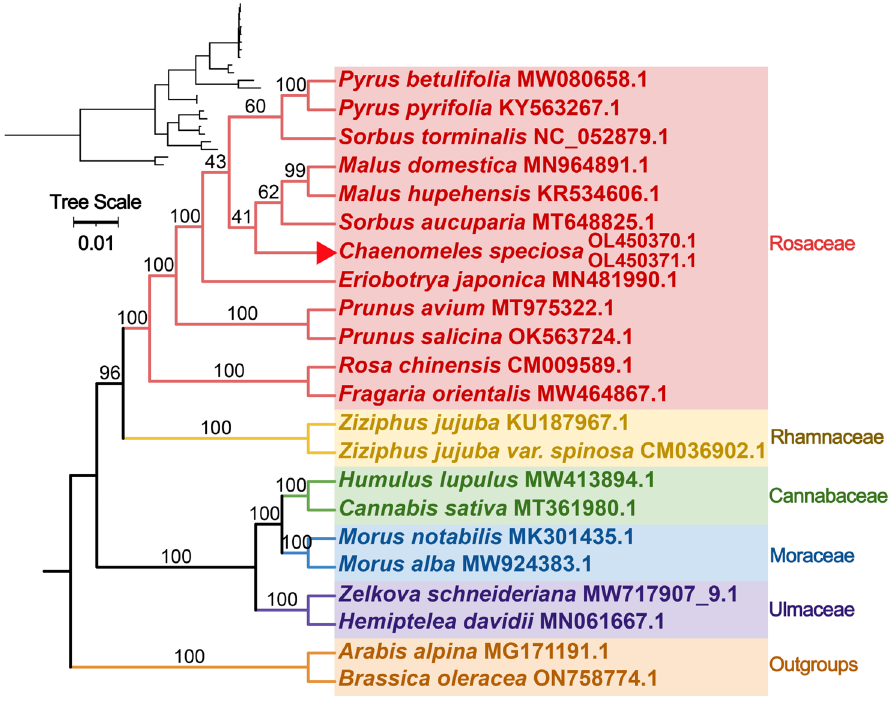
Figure 5. Phylogenetic tree based on 26 conserved PCGs. Two mitochondrial PCGs from A. alpina and B. oleracea, were settled as the outgroups, and the bootstrap support values were recorded at each